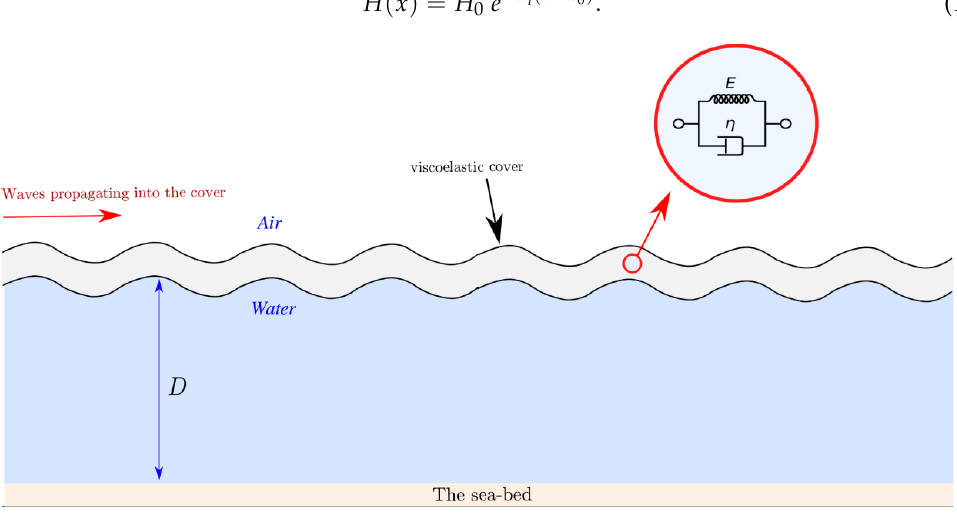
Figure 1. A schematic showing the concept of wave – ice interaction. Water waves propagate through a viscoelastic cover. Here, a Kelvin – Voigt model represents the solid motion occurring in the ice